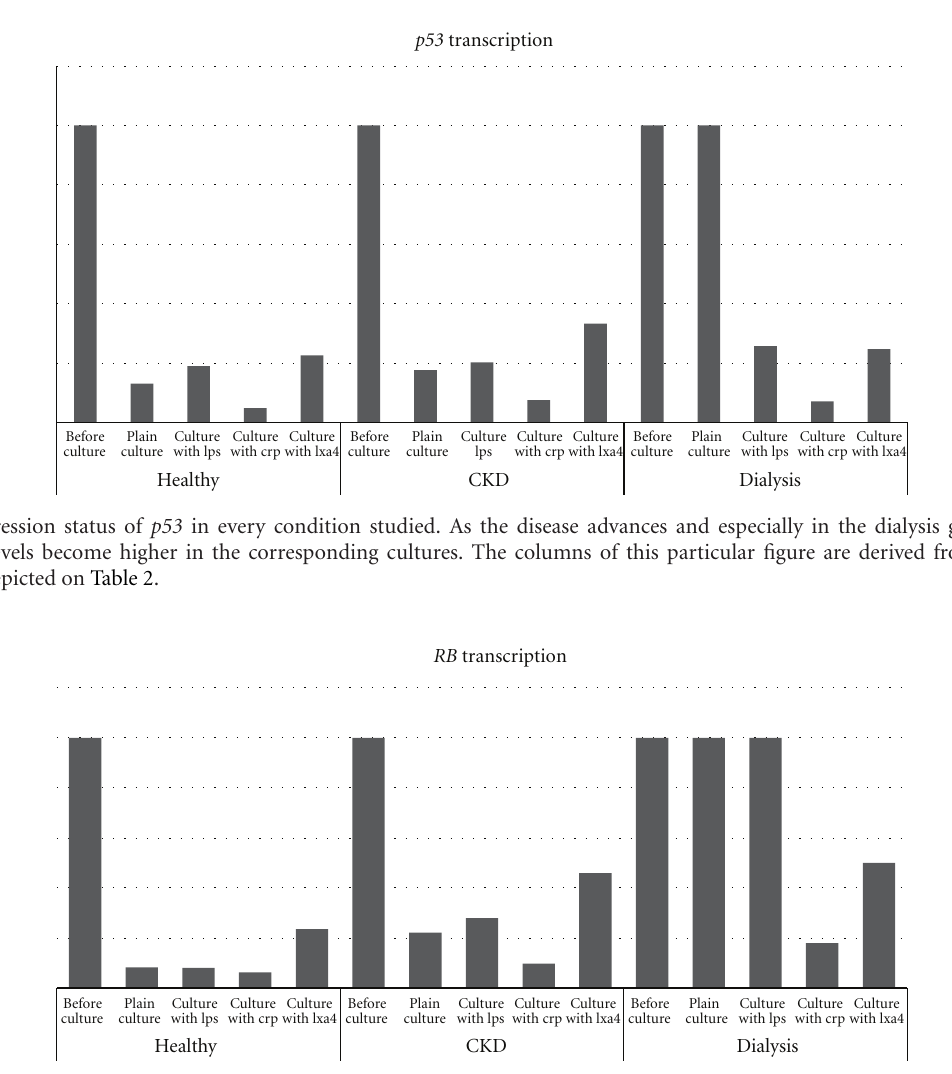
Figure 2: Expression pattern of RB in every possible group and condition. As the disease advances the gene’s transcription levels become higher in the corresponding cultures. No matter the culture conditions RB is transcribed highly in dialysis patients. The columns of this particular figure are derived from the pair wise comparisons depicted on Table